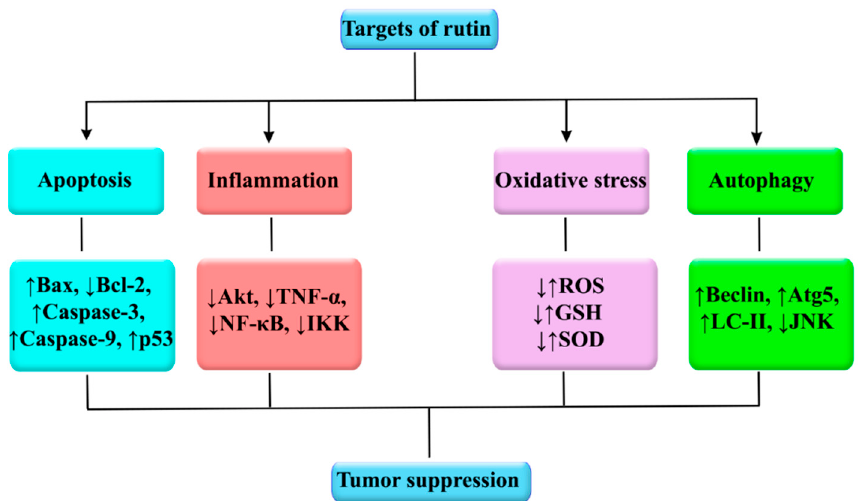
Figure5. Mainmoleculartargetsinfluencedbyrutinincancer. Akt,proteinkinaseB;Atg,autophagy-related gene; Bax, Bcl-2-associated X protein; Bcl-2, B-cell lymphoma 2; GSH, glutathione; IKK, I κ B kinase; JNK, Jun N-terminal Kinase; LC, light chain; NF- κ B, nuclear factor- κ B; ROS, reactive oxygen species; SOD, superoxide dismutase; TNF- α , tumor necrosis factor- α .